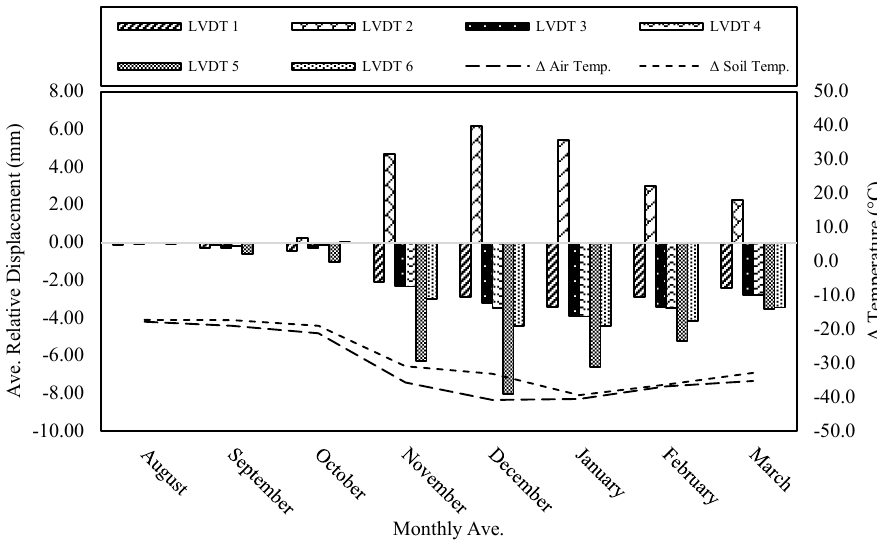
Figure 10. Average LVDT Displacement vs. Temperature.